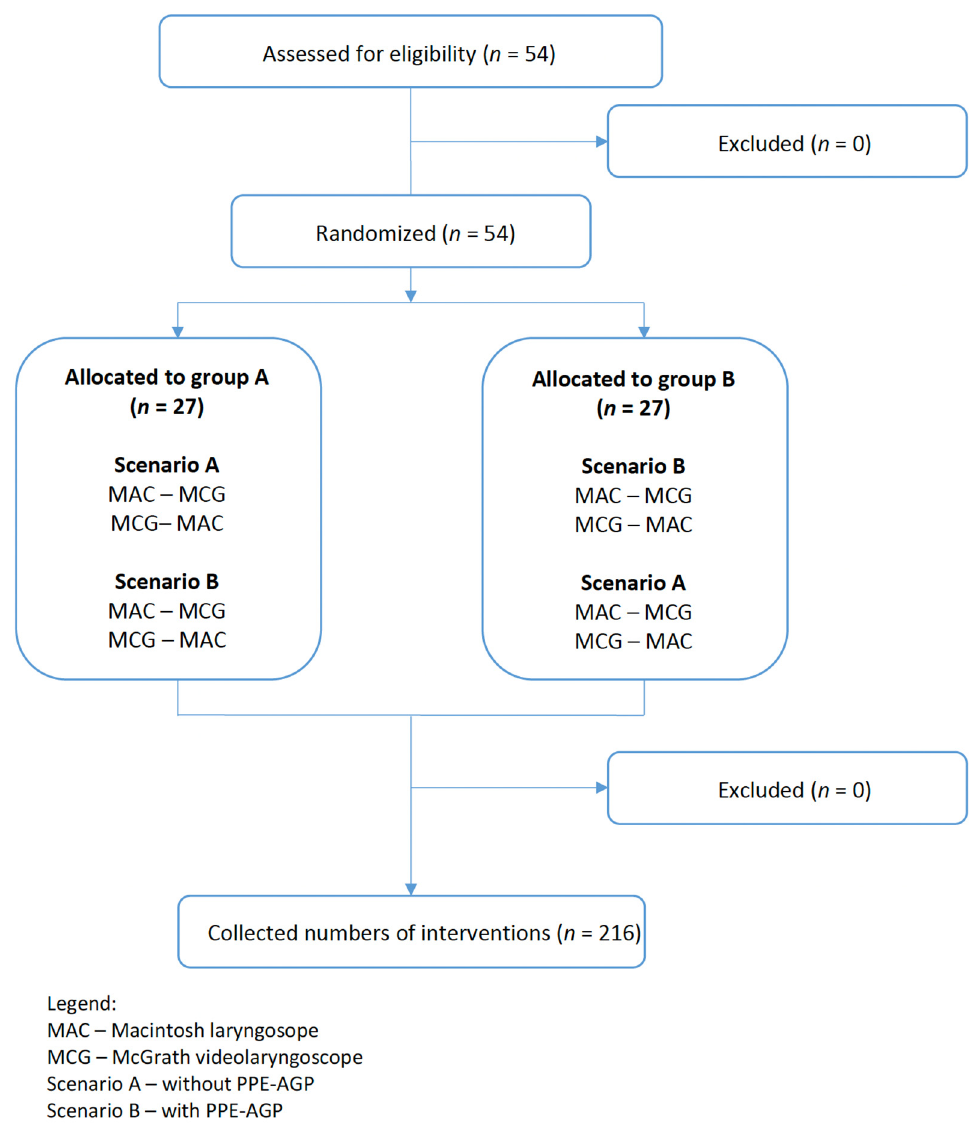
Figure 1. Randomization flow